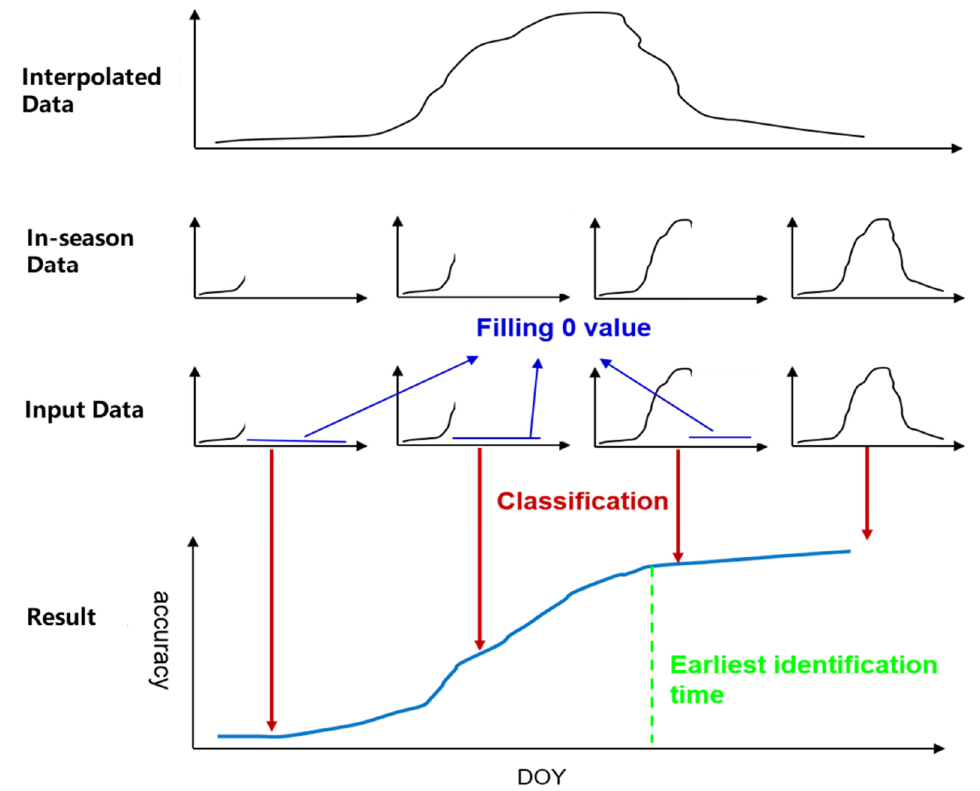
Figure 5. Illustration of the crops’ earliest identification time based on the Sentinel-2 time series data: (1) construct the Sentinel-2 time series vegetation index (VI) data, (2) acquire the in-season data, (3) fill in the missing value with 0 to maintain the length of the data, and (4) assess the accuracy and determine the earliest identification time.